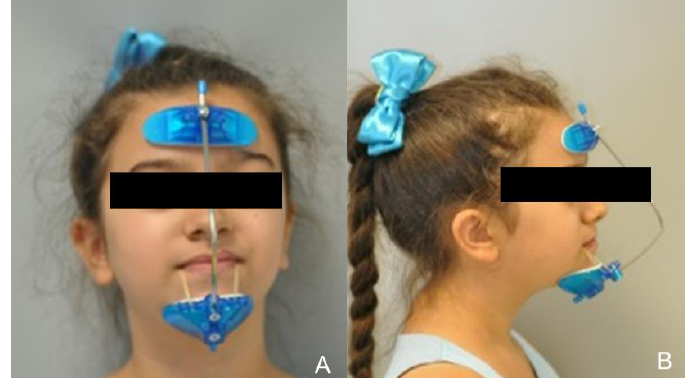
Figure 9. Extraoral traction. ( A ): Frontal view; ( B ): Lateral view.